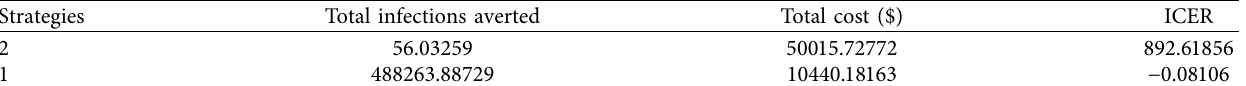
Table 3: Comparing cost and beneft of strategies 1 and